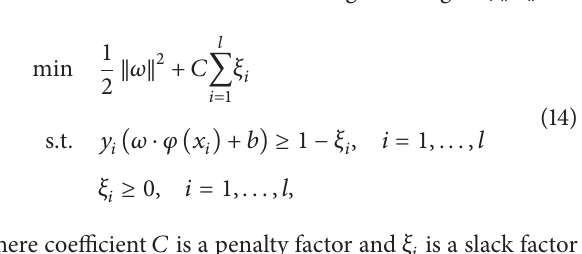
Figure 2: Illustration for data classification using a 2-class